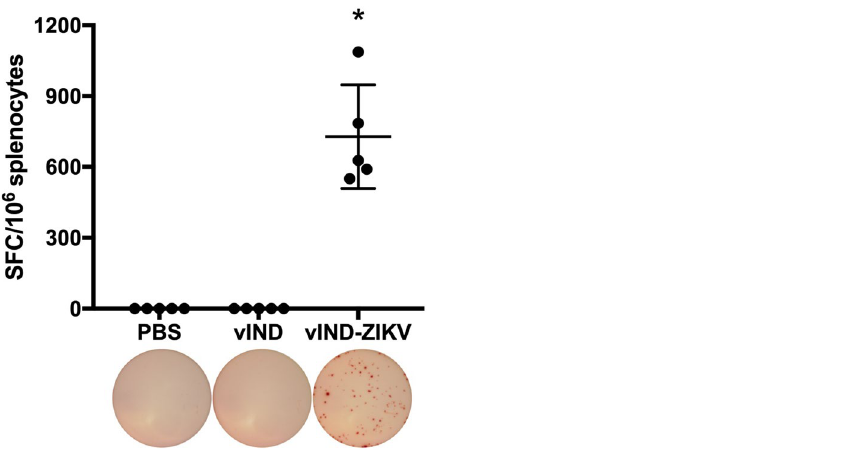
Figure 3. vIND-ZIKV vaccination stimulates antigen-specific IFN-γ-secreting splenocytes after 1 week. Antigen-specific IFN-γ-secreting splenocytes in C57BL/6 mice (n = 5) vaccinated intramuscularly with either PBS, vIND, or vIND-ZIKV (D4W) at 10 7 PFU were measured 7 days post vaccination by ELISPOT with E peptide IGVSNRDFVEGMSGG. Data is shown as spot-forming cells (SFC) per 10 6 splenocytes. Asterisk represents statistical significance (p < 0.01) with the Kolmogorov–Smirnov test when comparing to the PBS- vaccinated control group. Horizontal line represents mean and error bars represent SD. Images of representative wells are shown below each